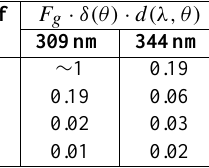
Table 1. The relative contribution of the diffused radiation into the measured radiation under different angular altitudes of the Sun Angular altitude of